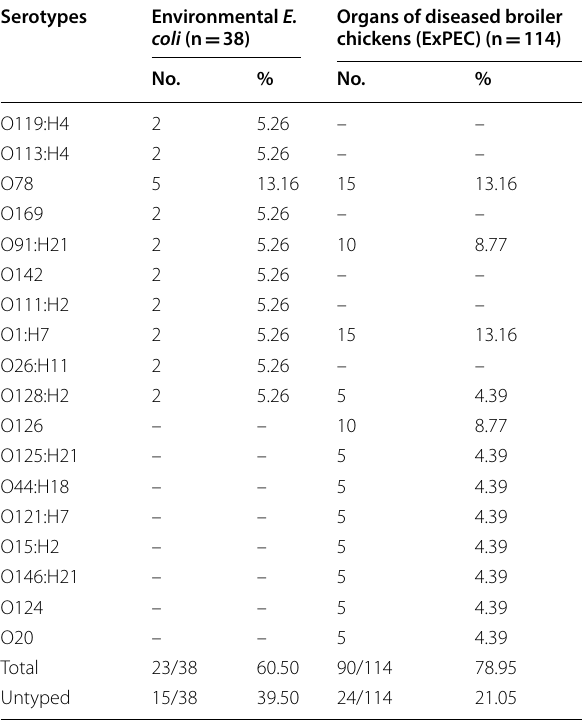
* Chi square (P < 0.0243)